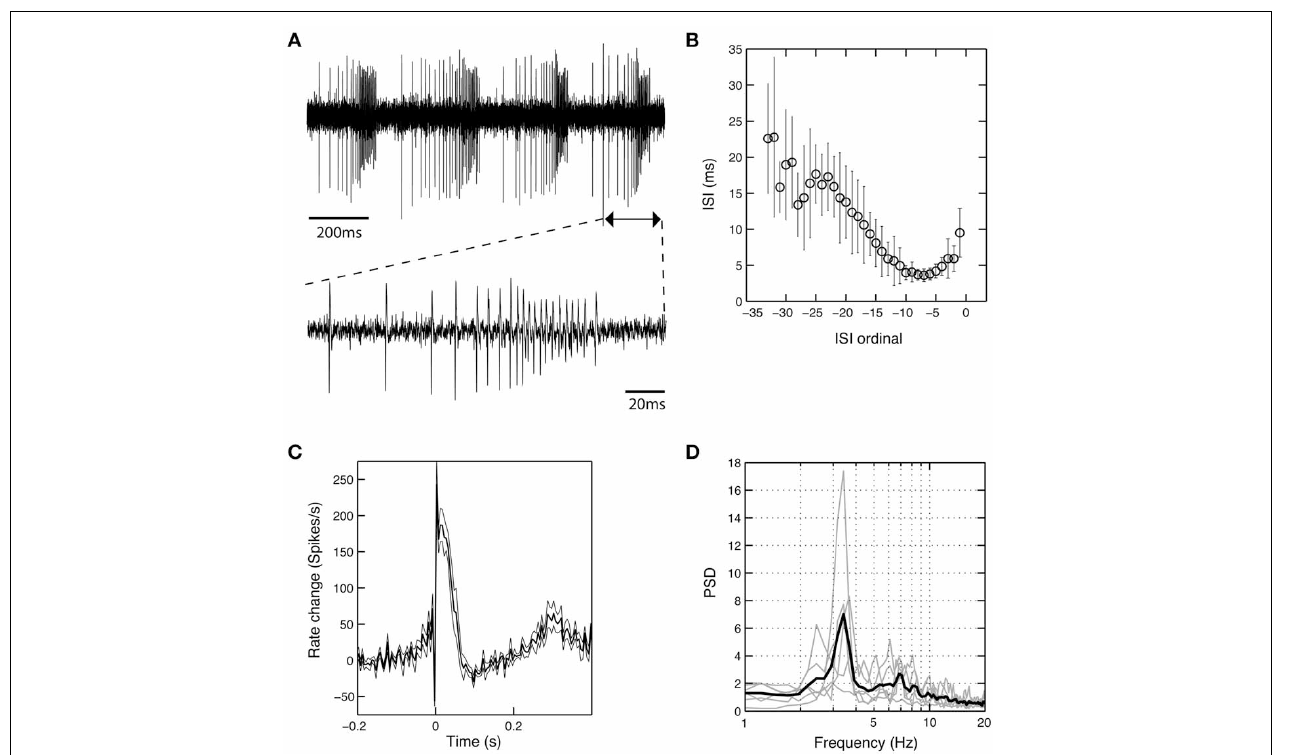
FIGURE 5 | A subset of theta-oscillatory GPi cells recorded in LA exhibited unique bursting properties. (A) Raw trace of a neuron recorded in the GPi of case 8 (operation under LA). Note the strong periodicity, the acceleration-deceleration spiking pattern and progressive spike amplitude reduction within bursts. Sub-panel shows a single burst on an expanded time-scale. (B) The acceleration-deceleration pattern resulted in a parabolic-like shape when ISI duration was plotted as a function of position within the burst (ISI ordinal). Pooled data from all bursts that were recorded from the visualized neuron, with alignment at the position of the last spike in a burst. Note the reduced variability in